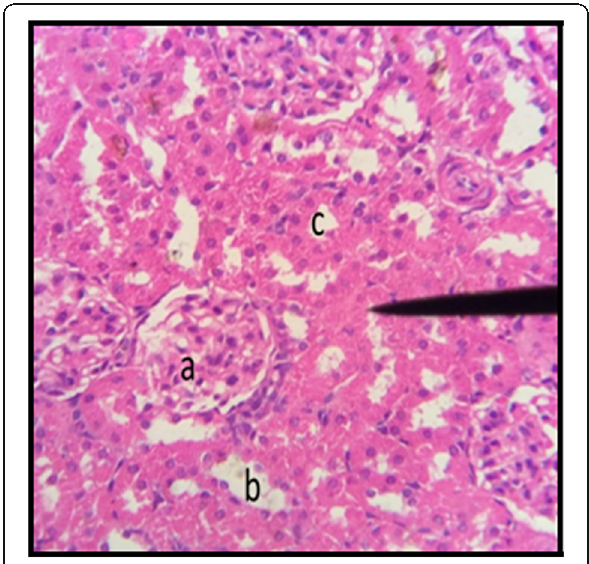
Fig. 4 Kidney Section of Female Rat (Control) X400. a normal glomerulus, b normal distal tubule, c normal proximal